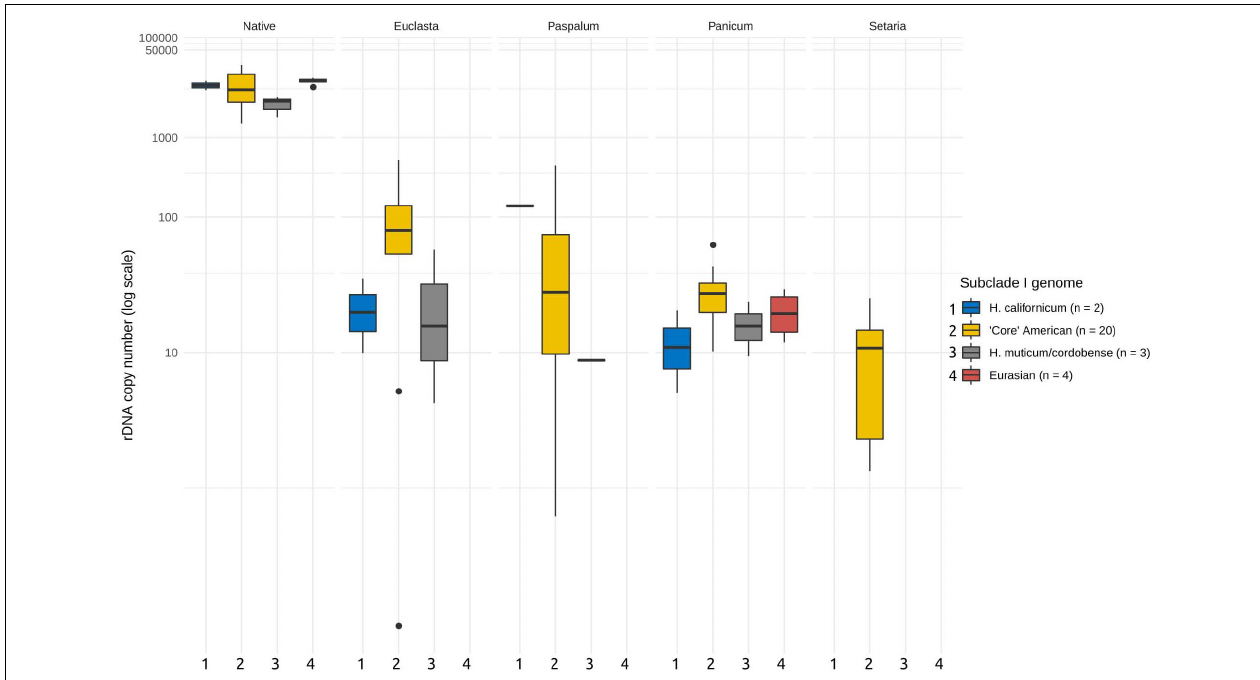
FIGURE 3 | Copy number variation of the foreign ribotypes in relation to major phylogenetic groups. Phylogenetic grouping is based on Brassac and Blattner (2015). Foreign ribotypes only occur in Hordeum species of sect. Stenostachys . No significant differences at P = 0.05 were revealed by ANOVA. Copy numbers of native ribotype are given for